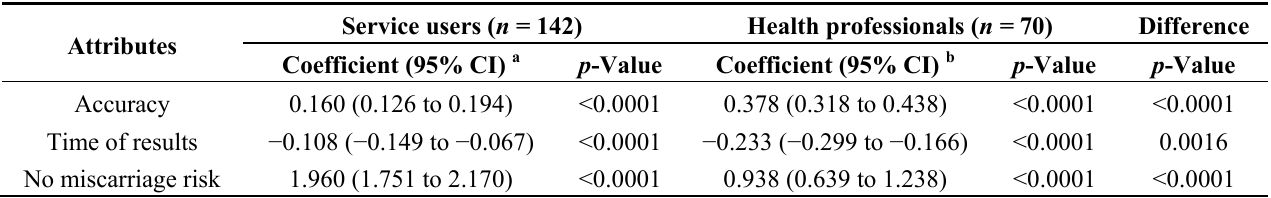
Table 1. Conditional logit analysis regression results for service users and health professionals.